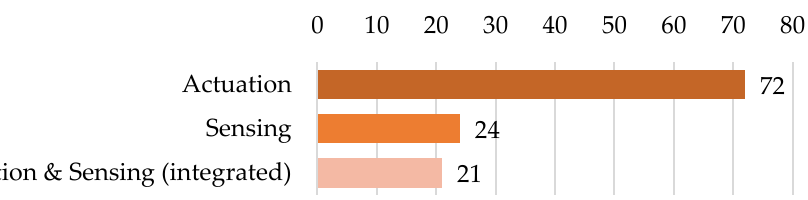
Figure 11. Distribution of the soft gloves among device